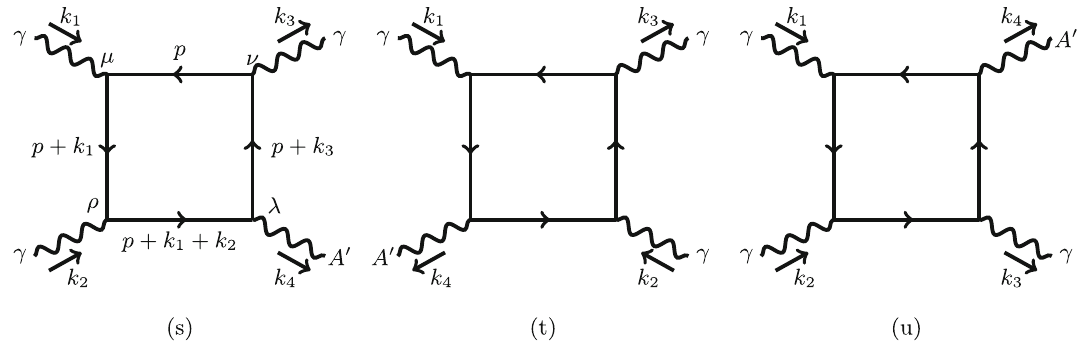
Fig. 1 Three Feynman diagrams of γγ → γ A (cid:2) , the other three differ from these only in that the internal electron loop is traversed in the opposite direction. Amplitude of the diagram with clockwise loop current gives the same contribution with anticlockwise current case